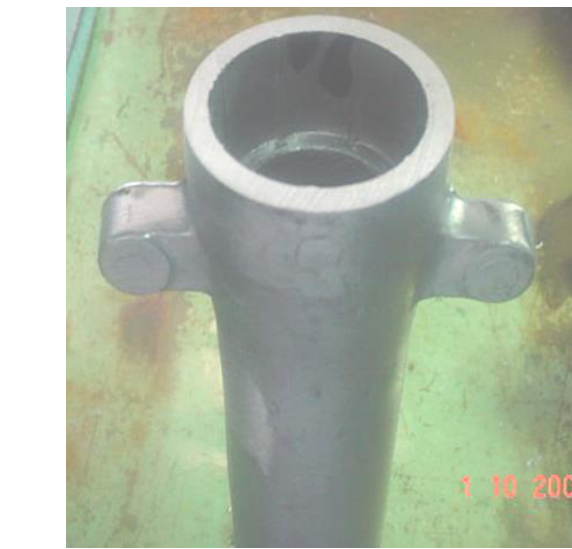
Figure 6. Bottom case before machining Figure 7. Bottom case after machining